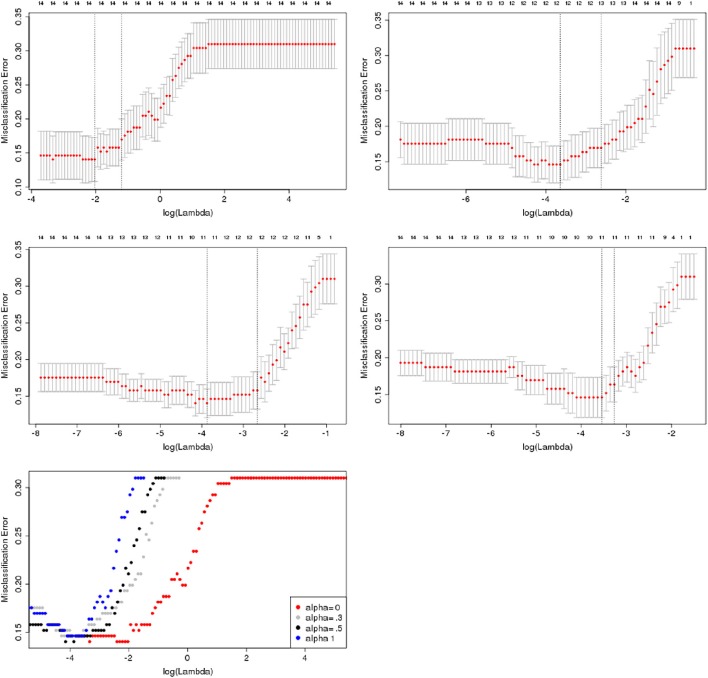
Selection of alpha parameter for penalized logistic regression. Misclassification error plotted against the range of lambda values (plotted on a logarithmic scale) for different values of α for a penalized logistic regression on the rs-fMRI data. Numbers on top of each graph indicate the number of selected variables. Error bars indicate the bootstrapped standard deviation for the misclassification error for each lambda value. The left bottom plot shows the different deviance curves on a unified scale, indicating that α = 0.5 yields the lowest deviance together with α = 0, corresponding to a ridge regression model.